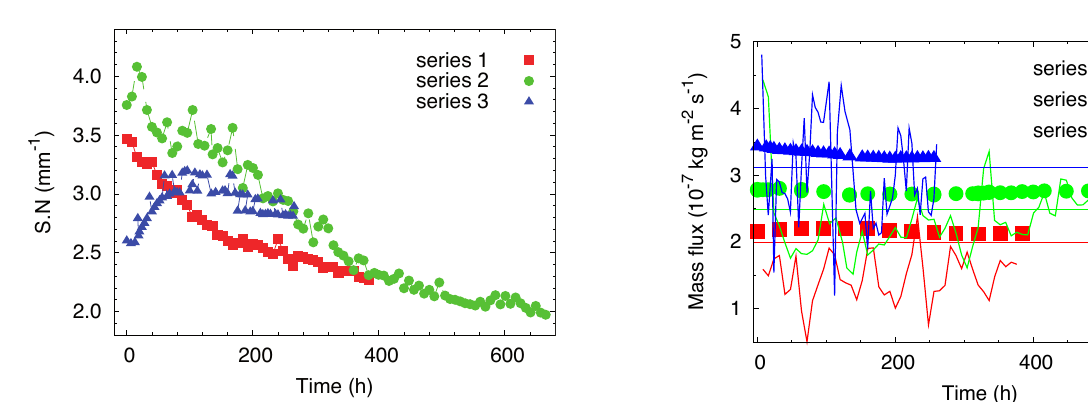
Fig. 11. Evolution of vapor flux in snow over time. Straight lines : flux j calculated from continuum theory, ignoring all microstructure and considering snow as a continuum with the diffusion constant of air. Jagged lines : flux j PIV measured by particle image velocimetry. Symbols : flux j FE calculated by numerically solving for the vapor pressure gradients in the microstructure for each time-step indepen- dently. Data are shown for all three series, each with different initial porosity and grain size. The vapor flux depends on both absolute temperature and temperature gradient, but is independent of poros- ity and